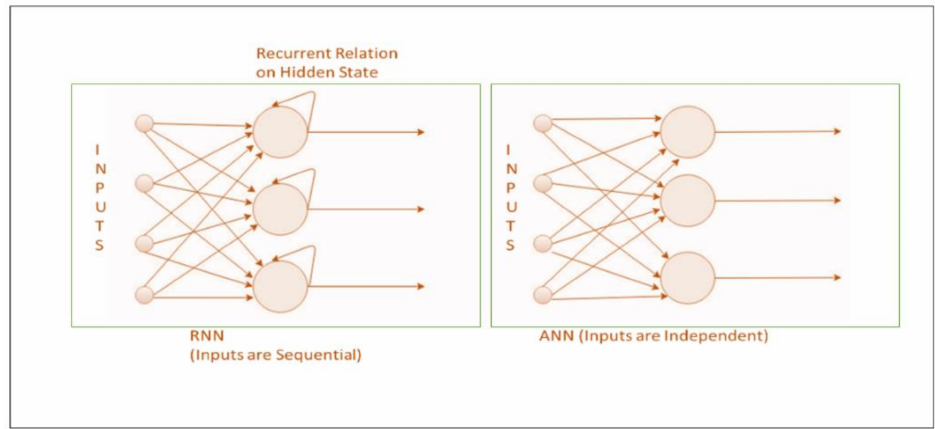
Figure 5. A simple illustration of RNN and